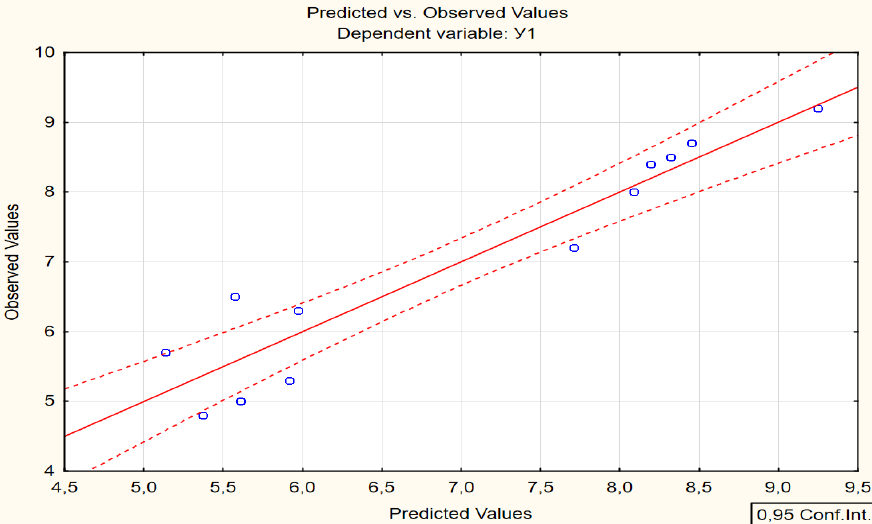
Figure 4. Observed and predicted values for the dependent variable (Y1).